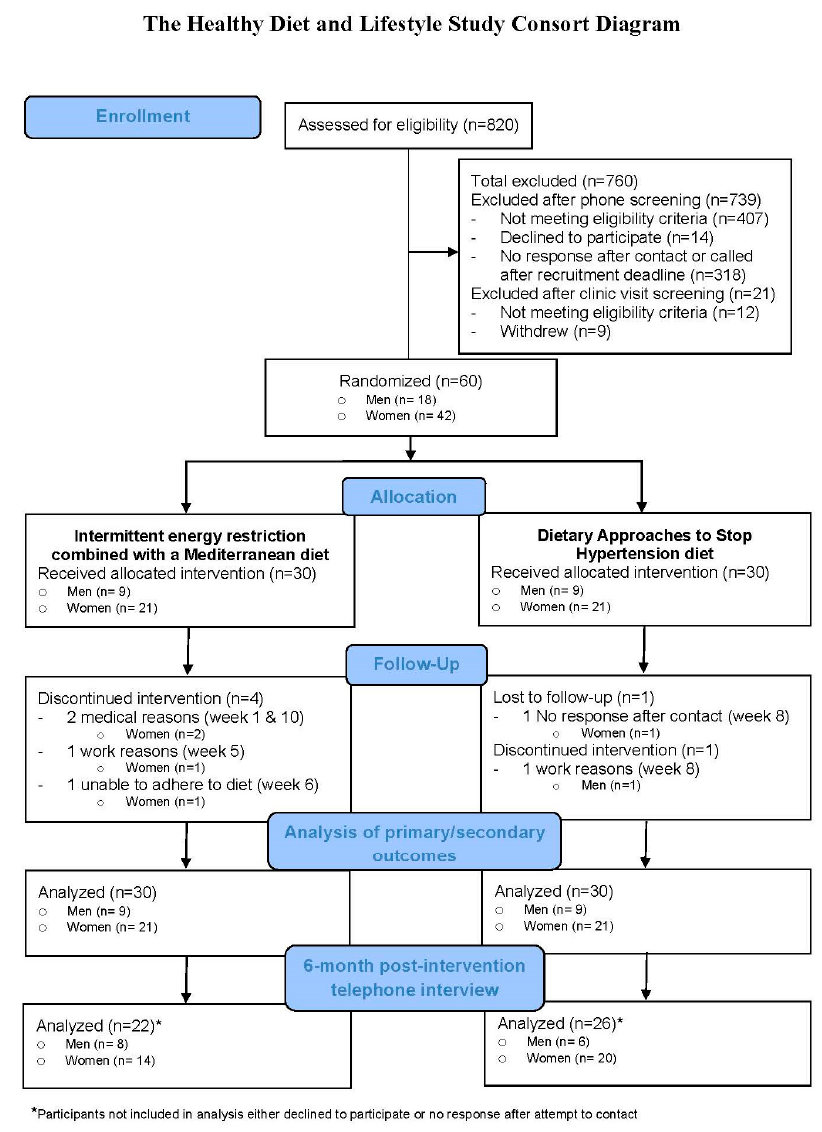
Figure 1. Consort Figure 1. Consort diagram.